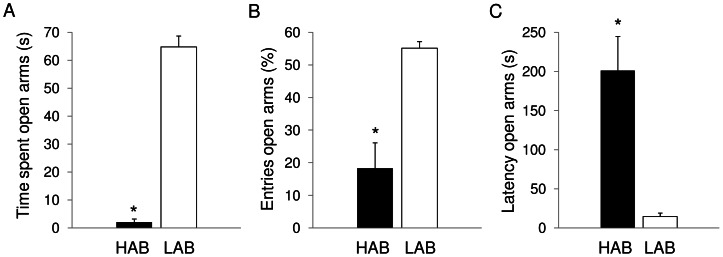
Behavior on the elevated plus maze.For high-anxiety behavior (HAB, n = 10) and low-anxiety behavior (LAB, n = 10) rats, data are expressed as means (±SEM) of: (A) time spent in the open arms (% of total time), (B) number of entries in the open arms (% of total entries), and (C) latency to enter an open arm (s). * indicates a significant difference between HAB and LAB rats (p<0.01).